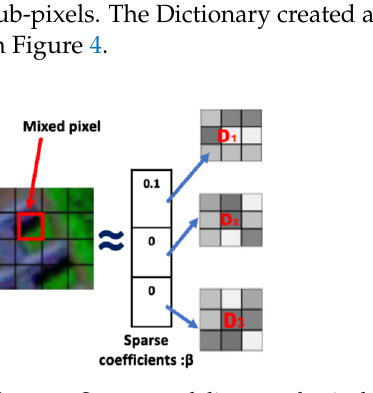
Figure 4. Sparse modeling at sub-pixel level using the pre-learned